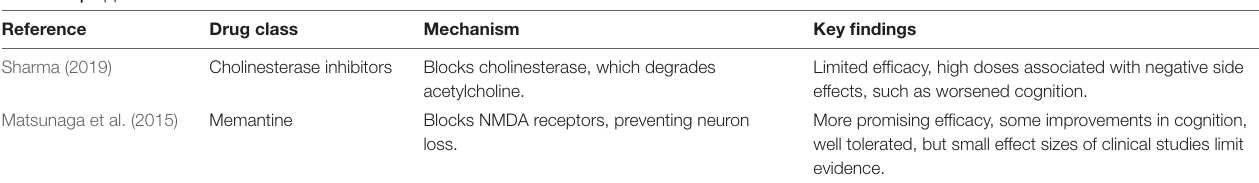
TABLE 2 | Approved Alzheimer’s disease